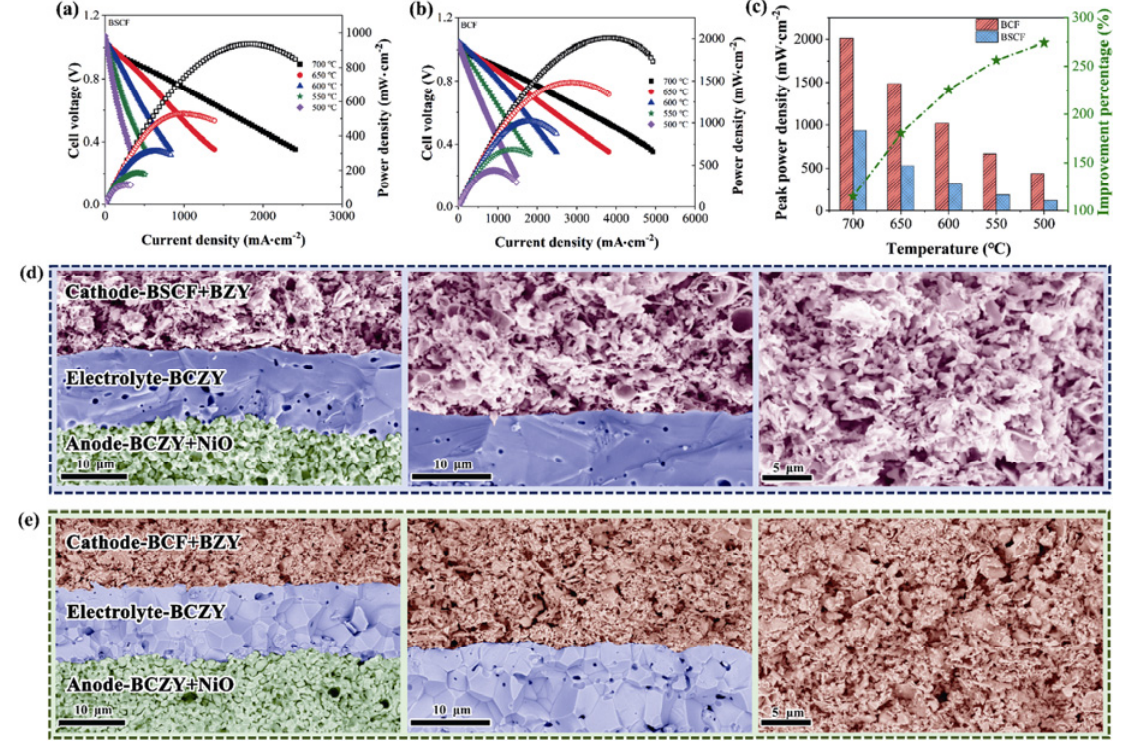
Fig. 5 Fuel cell performance for (a) BSCF cell and (b) BCF cell; (c) comparison of peak power densities between the BSCF cell and the BCF cell as well as the improvement percentage. SEM images for (d) BSCF cell and (e) BCF